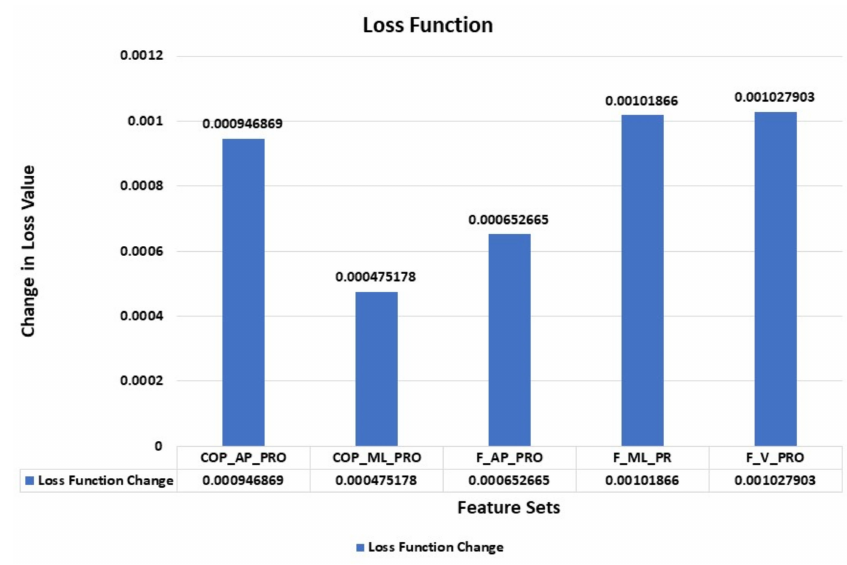
Figure 15. Loss Function Change for 5 bilateral feature sets.